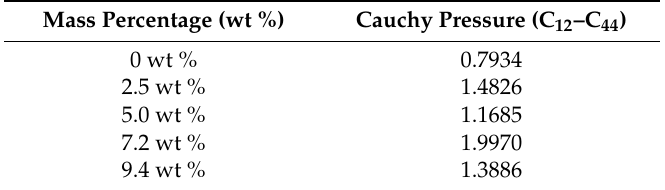
Table 2. Cauchy pressure of five different composite models (average value).